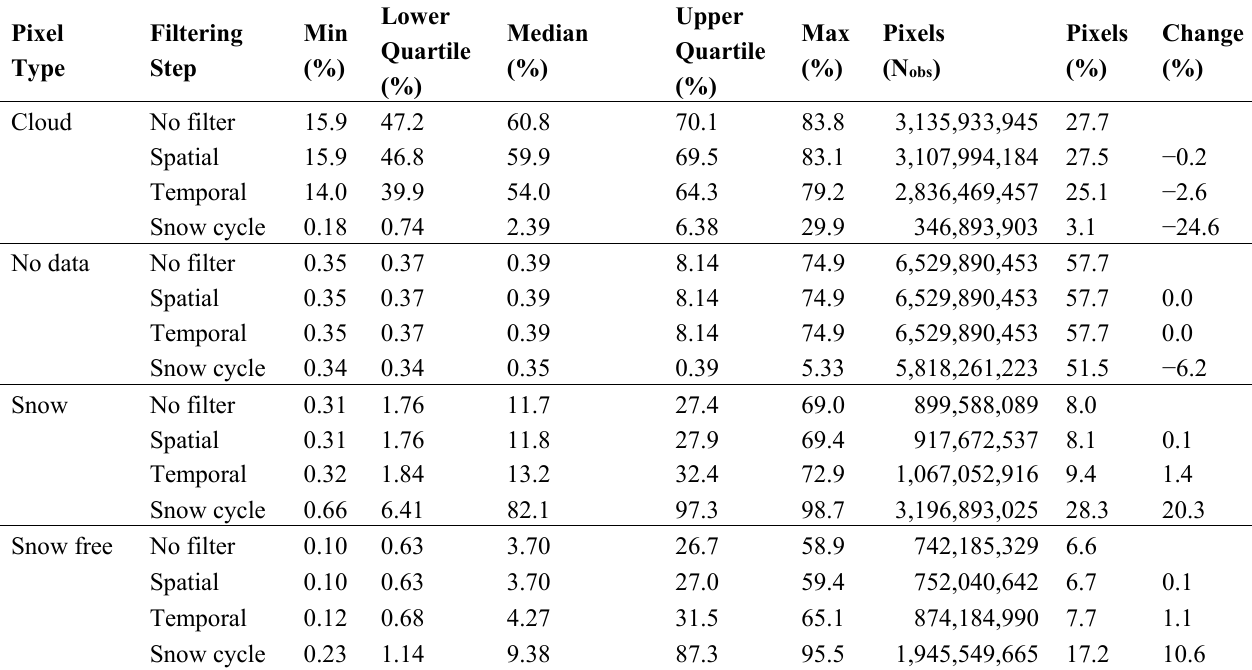
Table 2. Quantitative assessment of classification after each type of filtering shown in Figure